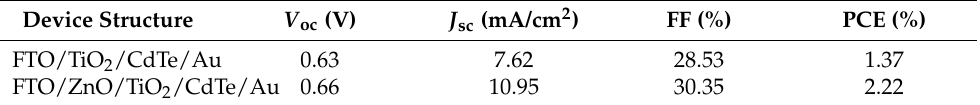
Figure 3. J – V characteristics of FTO/ZnO/TiO 2 /CdTe/Au and FTO/TiO 2 /CdTe/Au devices ( a ) under light and ( b ) dark. Table 1. Summarized performances of CdTe-TiO 2 heterojunction solar cells w/o ZnO film Device